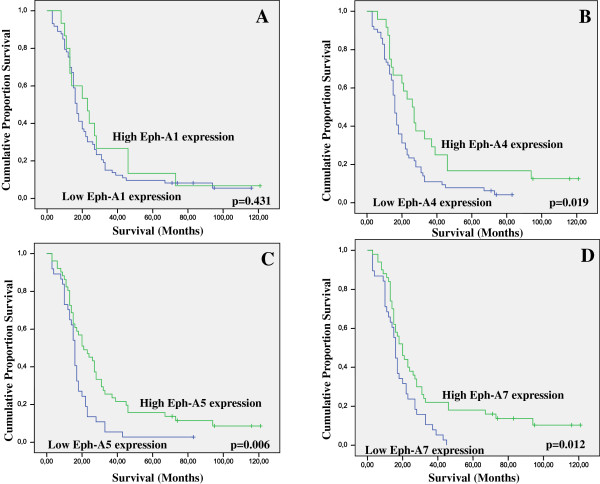
Kaplan-Meier survival analysis stratified according to A. EphA1, B. EphA4, C. EphA5 and D. EphA7 expression in 88 NSCLC patients (–complete cases; + censored cases).